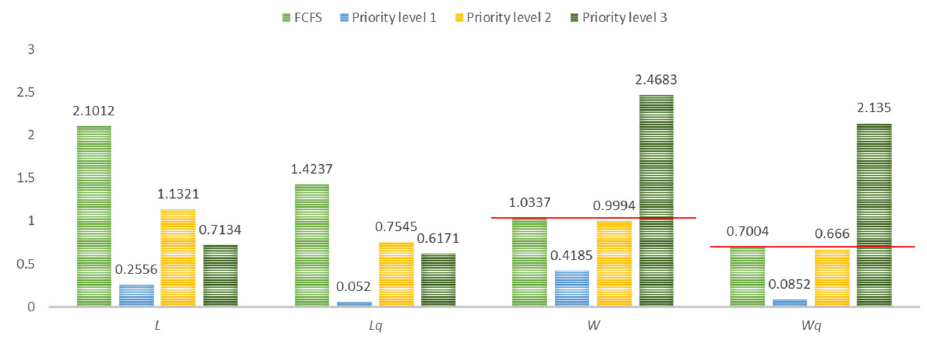
Figure 6. Comparison of performance indicators: FCFS rule vs. preemptive priorities.